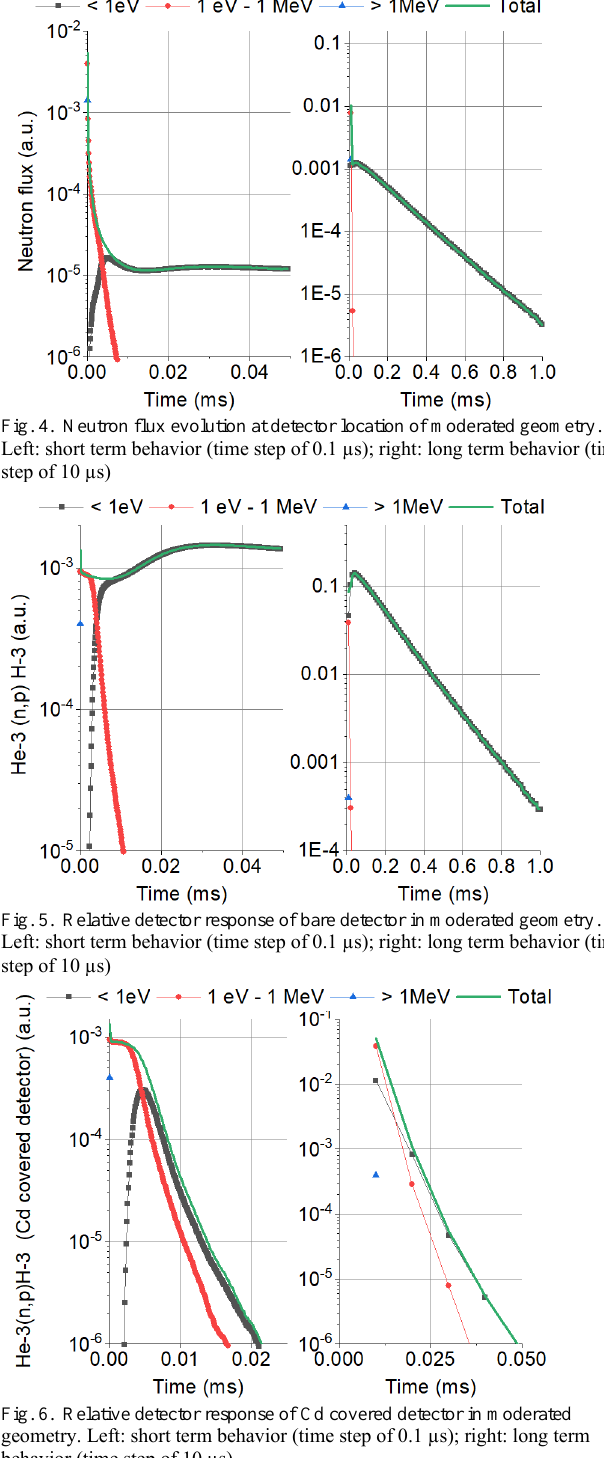
Fig. 6. Relative detector response of Cd covered detector in moderated geometry. Left: short term behavior (time step of 0.1 µs); right: long term